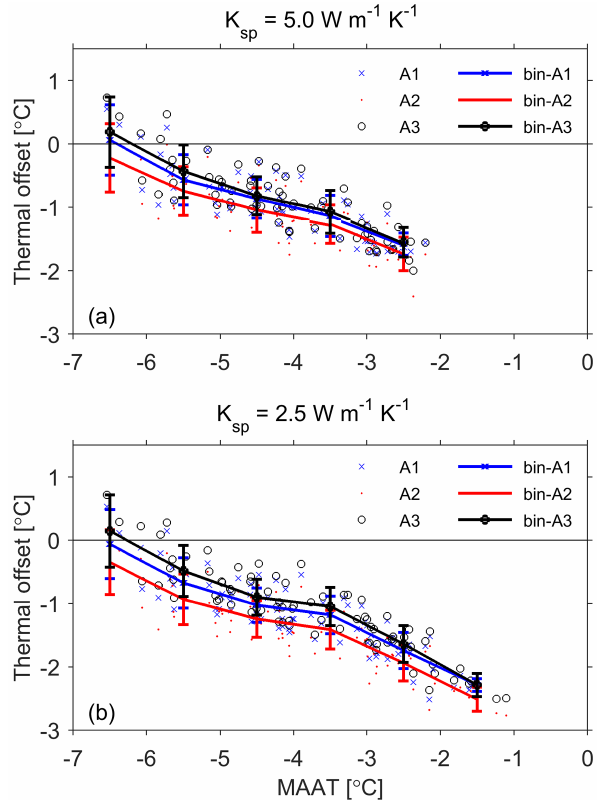
Figure 10. Thermal offset as a function of mean annual air temper- ature (MAAT) obtained from the simulations for the period 1980– 2100 of the three soil architectures, A1, A2 and A3. The lines con- nect the means of 1.0 ◦ C-bins, the bars indicate the corresponding standard deviations. The upper frame is for λ sp = 5.0Wm − 1 K − 1 , the lower one for λ sp = 2.5Wm − 1 K − 1 .